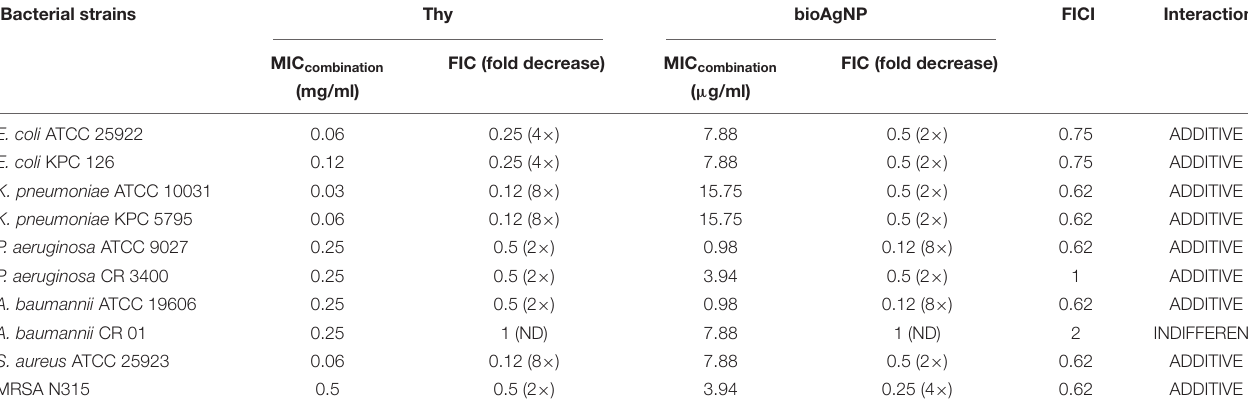
TABLE 4 | Effect of thymol (Thy) combined with biological silver nanoparticles (bioAgNP) against five bacterial species, including reference and multidrug-resistant strains. Bacterial strains Thy